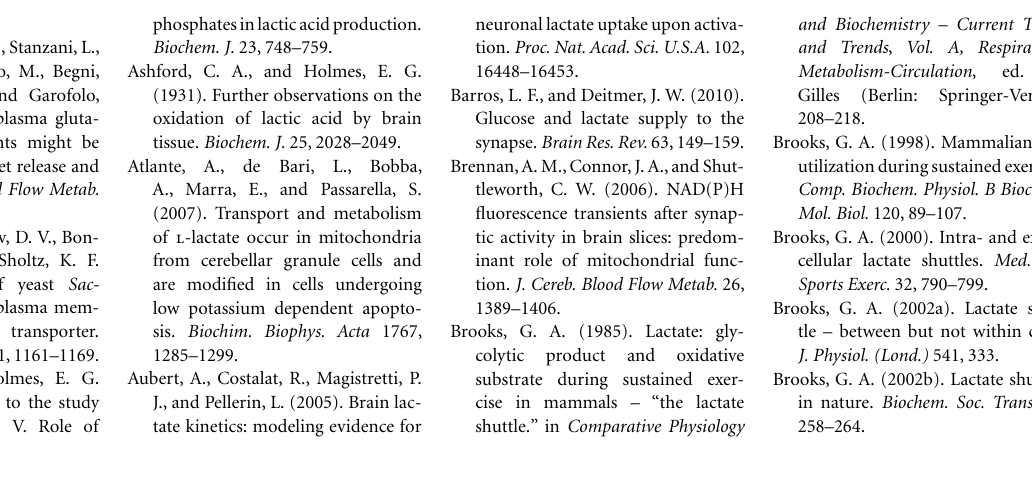
(Figures 4 and 7). In addition, the left panel illustrate the ability of NADH, formed during lactate conversion to pyruvate in the neuronal mitochondrial membrane, to neutralize Glut-induced ROS-produced